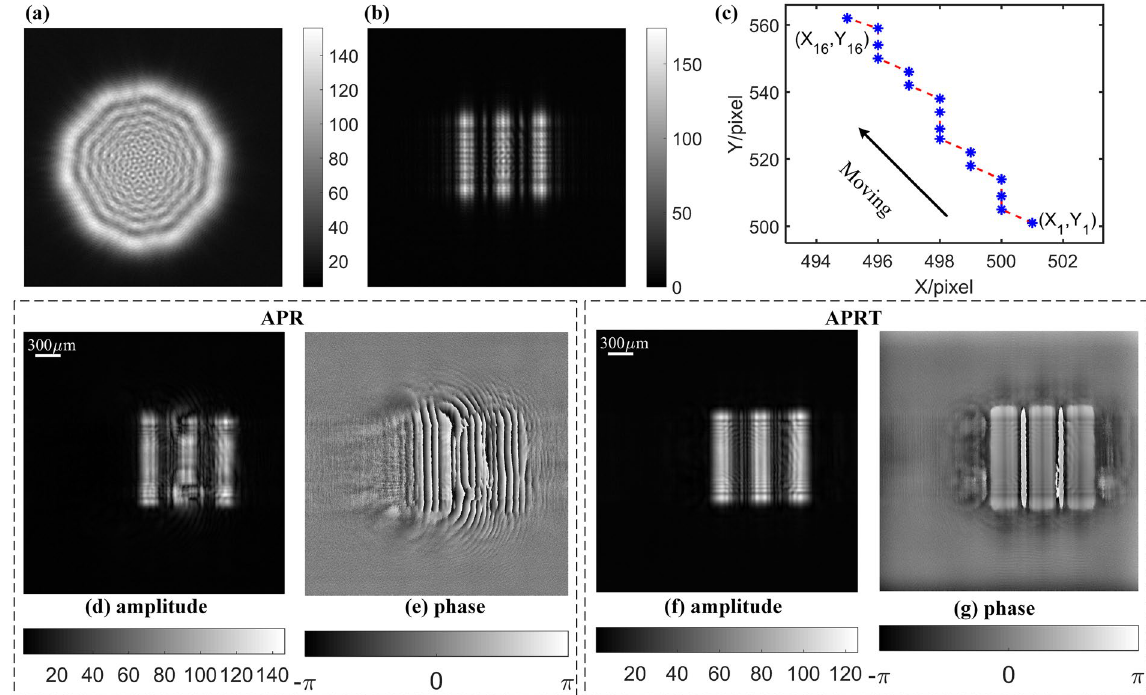
Figure 5. Recorded data and reconstructed complex amplitude in Z 0 = 50 mm, d = 2 mm, N = 16, M = 1000: ( a ) Diffraction disc of incident light in Z 1 = 50 mm. ( b ) Diffraction pattern in Z 1 = 50 mm. ( c ) The movement of the peak position of cross-correlation; ( d ) and ( e ) are reconstructed amplitude and phase by APR algorithm, respectively; ( f ) and ( g ) are reconstructed amplitude and phase by APRT algorithm, respectively. Here iterative number is equal to